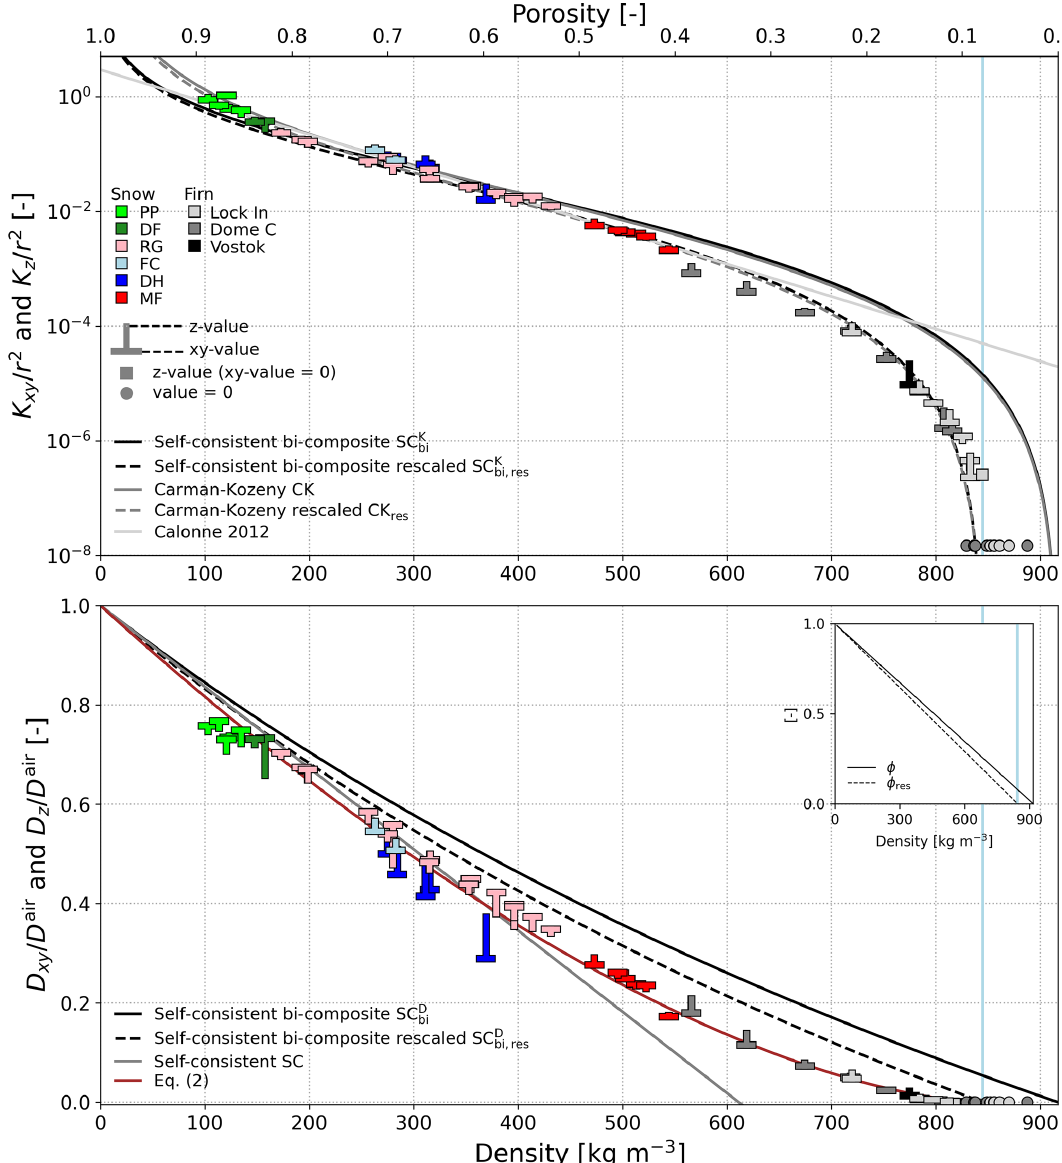
Figure 2. Dimensionless permeability and normalized diffusion coefficient of snow and firn versus density: computations from the 3D images (“T” symbols) and analytical models (lines). The proposed regression Eq. (2) is also shown. Snow types correspond to the ICSSG (Fierz et al., 2009): precipitation particles (PPs), decomposed and fragmented particles (DFs), rounded grains (RGs), faceted crystals (FCs), depth hoar (DH), and melt forms (MFs). The vertical blue lines at 845kgm − 3 indicate the close-off density. The sub-caption shows the relationships of the rescaled porosity φ res (Eq. 1) compared to the total porosity φ with